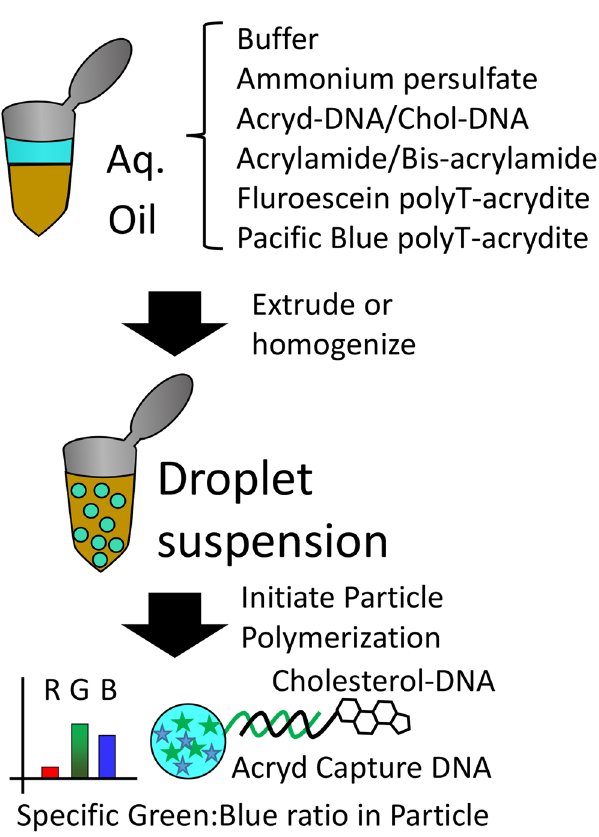
Figure 6. Schematic of procedure for generating DNA-decorated, polyacrylamide hydrogel